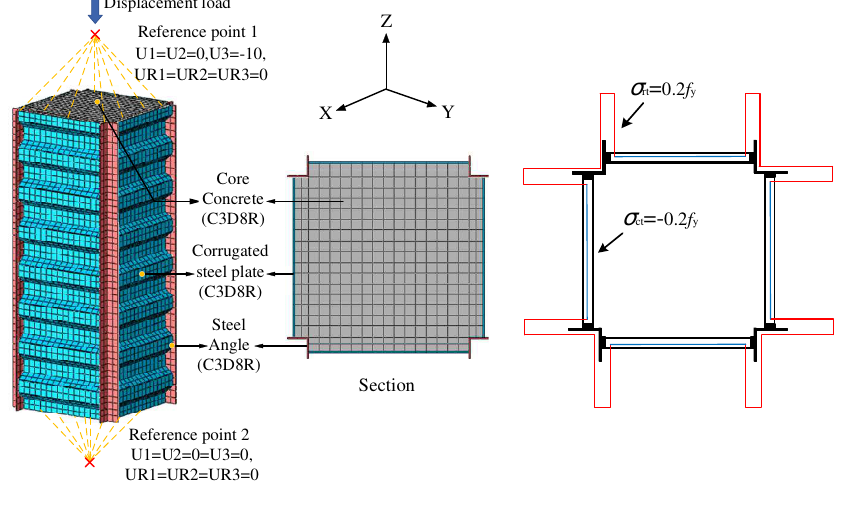
Figure 11. FE model of SA-CS